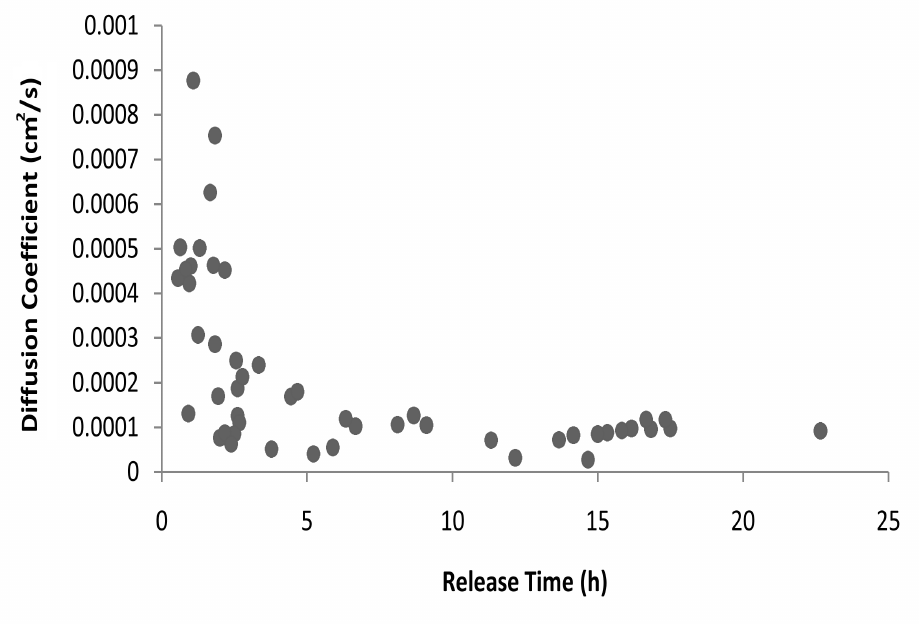
Figure 2. Cumulative nutrient release time with diffusion